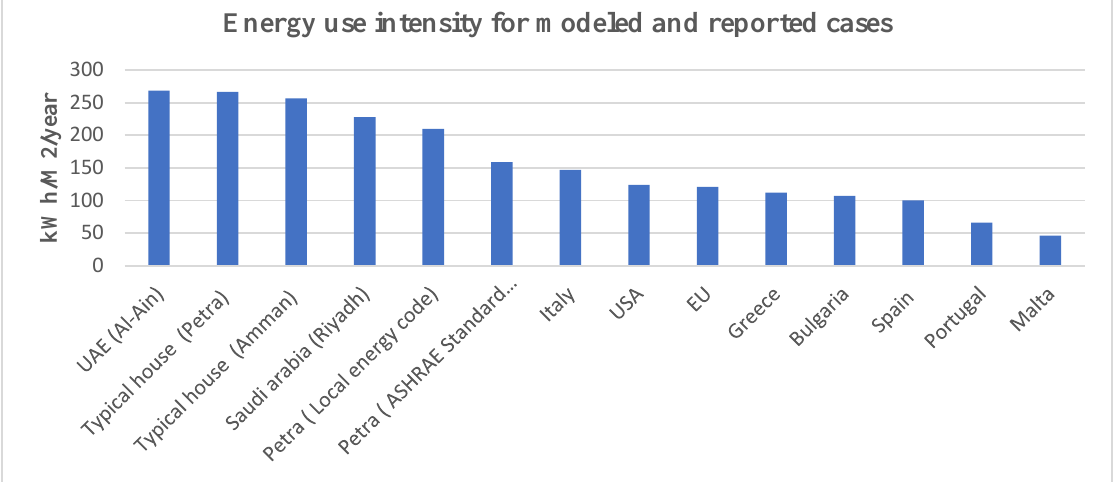
Figure 9. Energy-use intensity in the residential sector for different reported cases and countries.